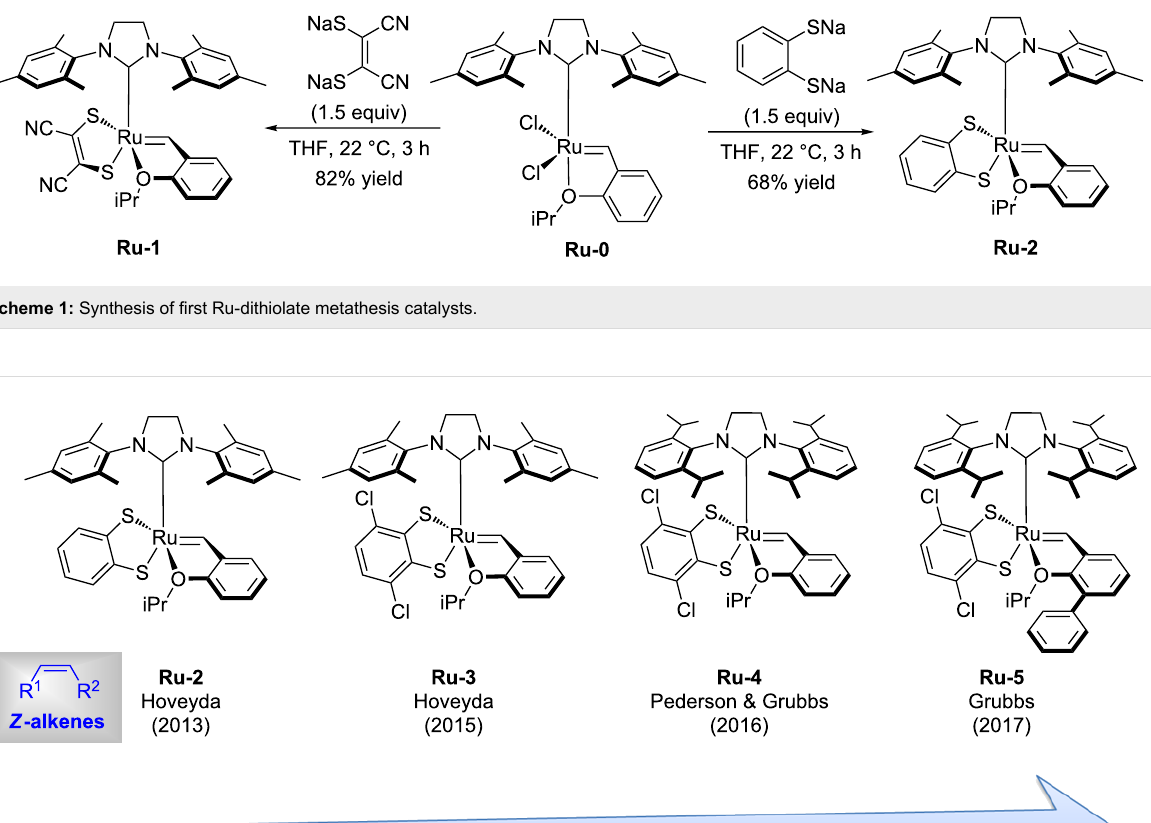
Figure 1: Most efficient Ru-dithiolate catalysts for stereoretentive olefin metathesis with Z - and E -alkenes as starting materials (activity increases from left to right).